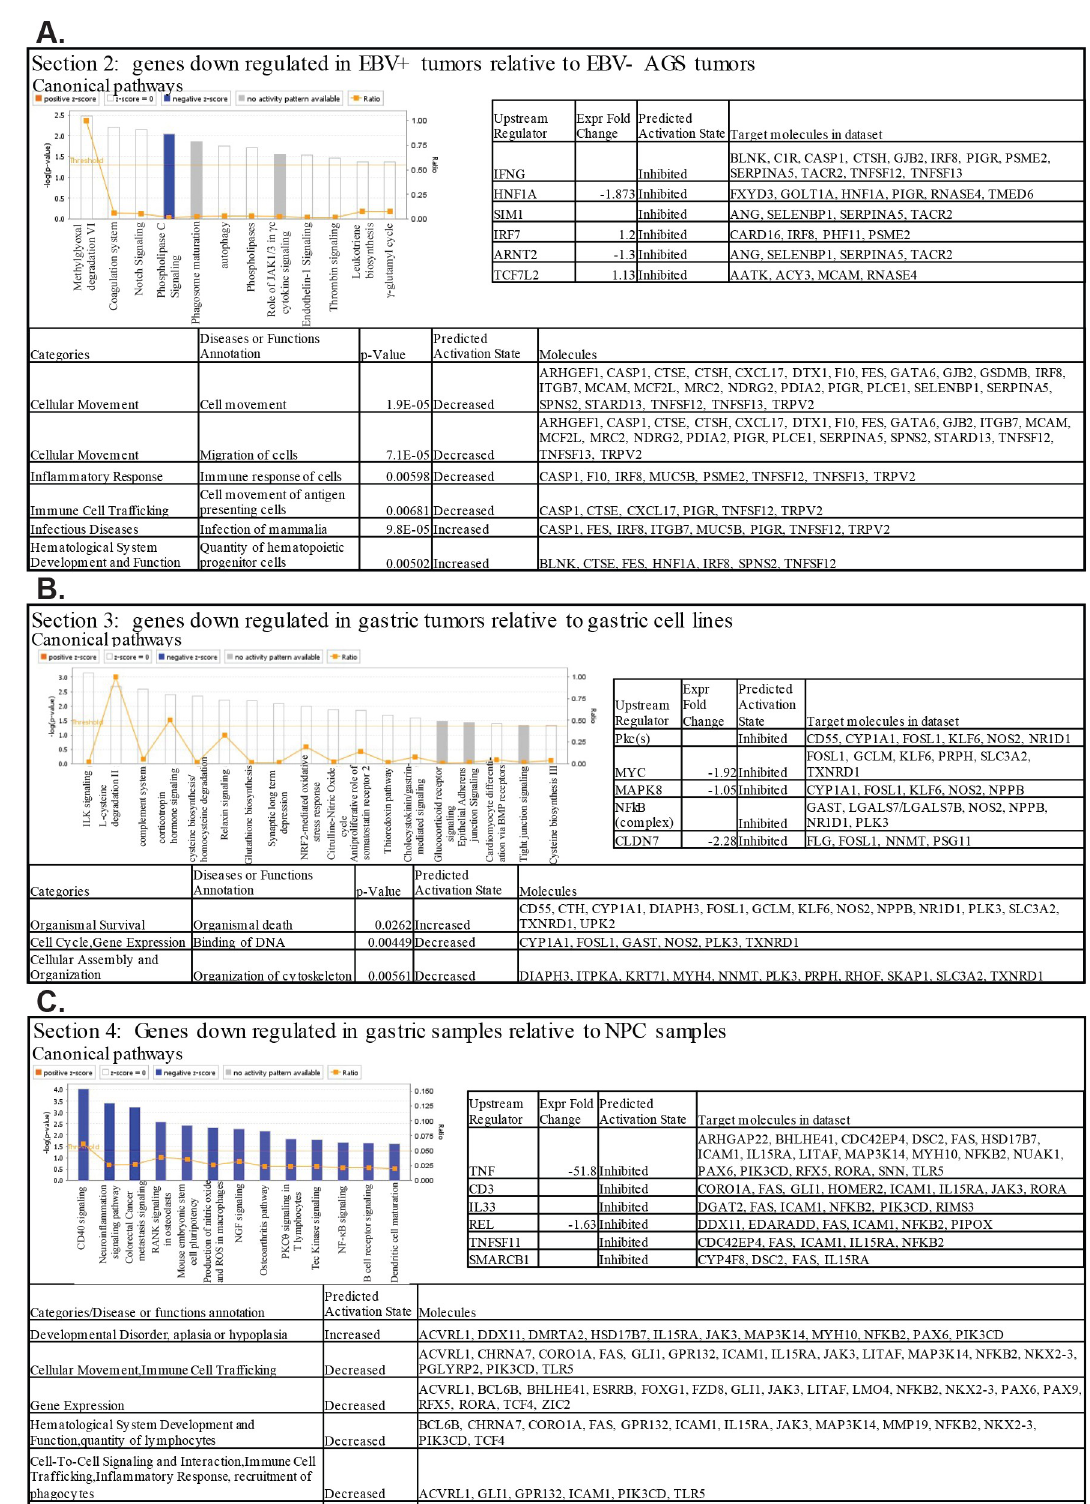
EBV effects on cellularexpressionin culture and duringtumor growth in vivo